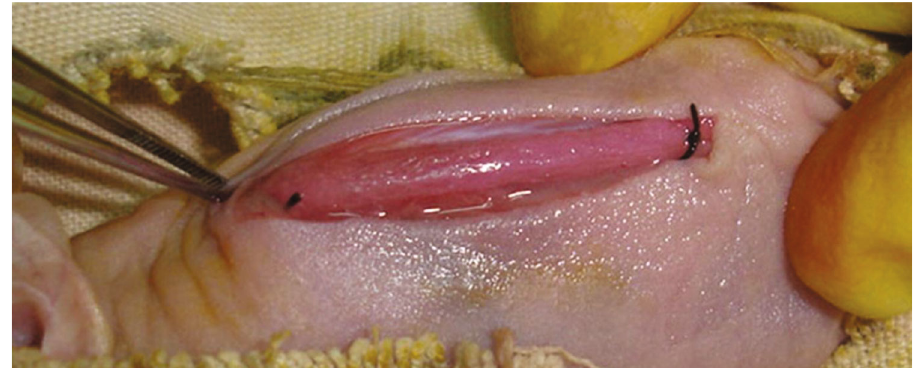
Figure 3: Engineered tendon transplanted into the back of a nude mouse to exert physiological mechanical stimulation. The construct is sutured to the fascia, which receives mechanical stretching caused by the natural movement of the mouse back. Reprinted from Biomaterials (2010), Vol. 31, Chen JL, et al., E ffi cacy of hESC-MSCs in knitted silk-collagen sca ff old for tendon tissue engineering and their roles, Pages 9438-9451, Elsevier (2010), with permission from